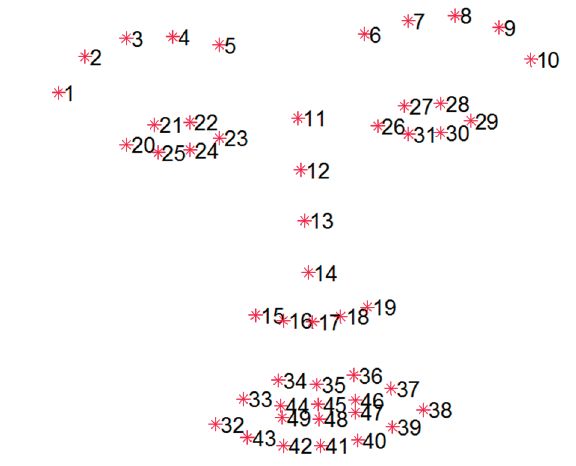
Figure 1. Total of 49 points mark-up used for feature